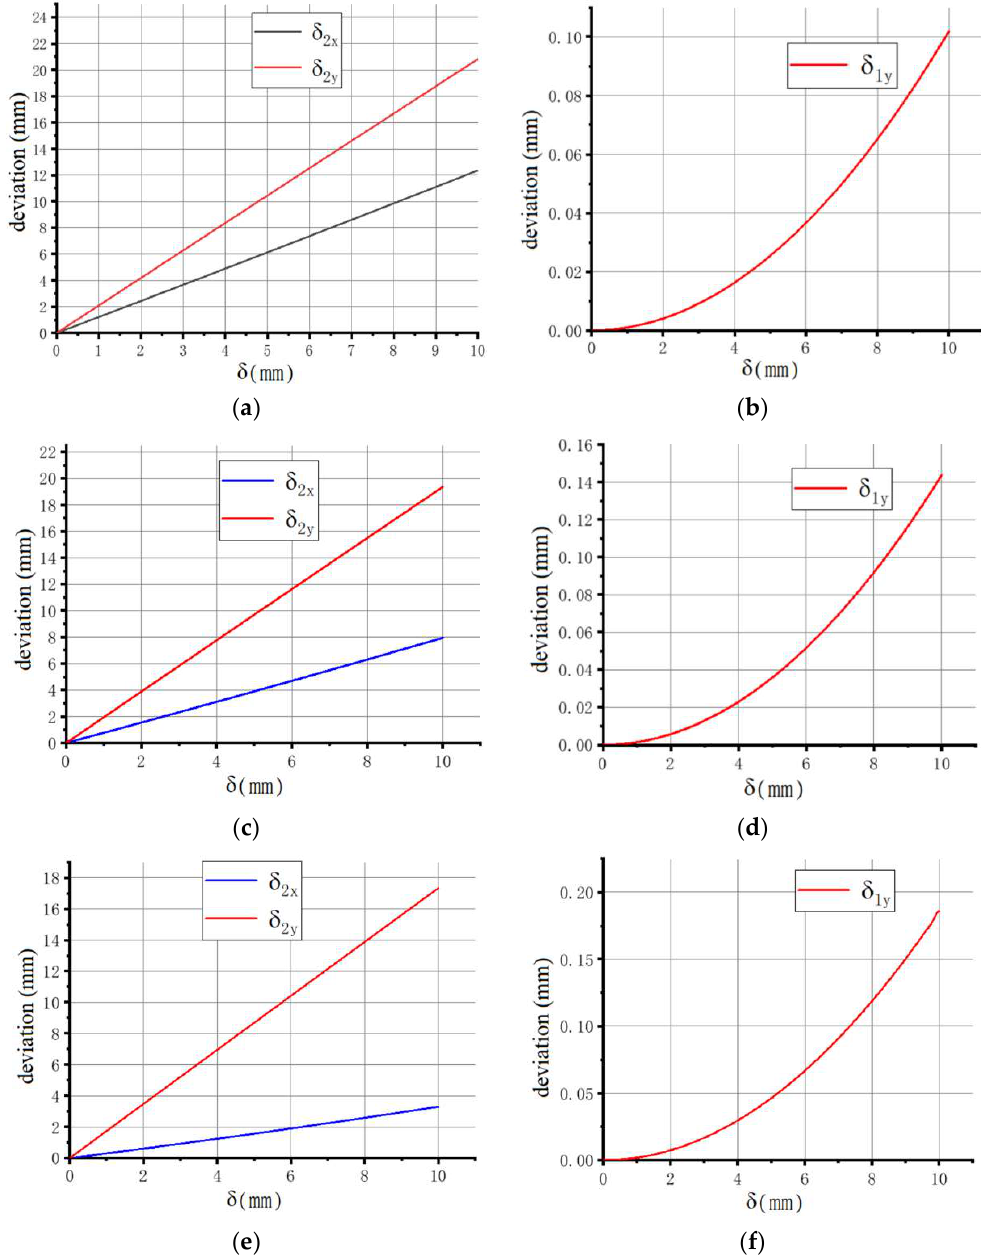
Figure 4. Deviation relation curve: ( a ) driving roller deviation (clamping 311 drilling tool); ( b ) drilling tool deviation (clamping 311 drilling tool); ( c ) driving roller deviation (clamping 168 drilling tool); ( d ) drilling tool deviation (clamping 168 drilling tool); ( e ) driving roller deviation (clamping 89 drilling tool); ( f ) drilling tool deviation (clamping 89 drilling tool).